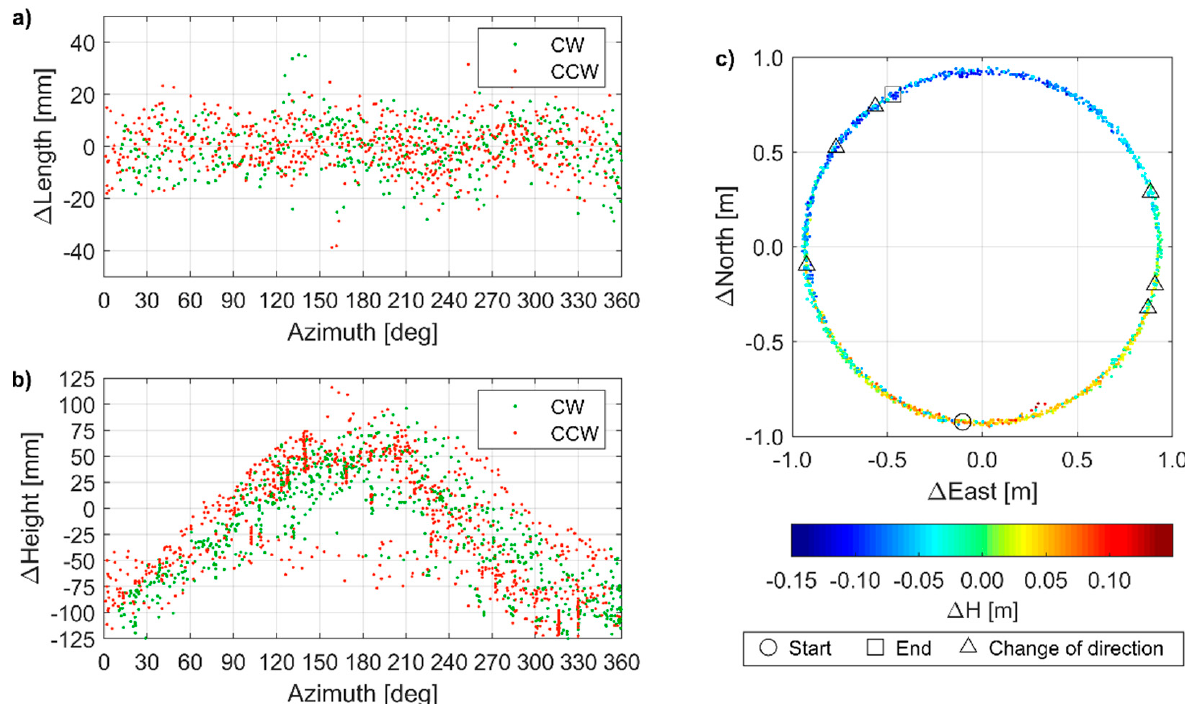
Figure 8. Positioning error in consecutive epochs: ( a ) for baseline length; ( b ) for the height differ- ence. Dashed black lines indicate changes in the rotation direction (CW—clockwise, CCW—coun- ter-clockwise).